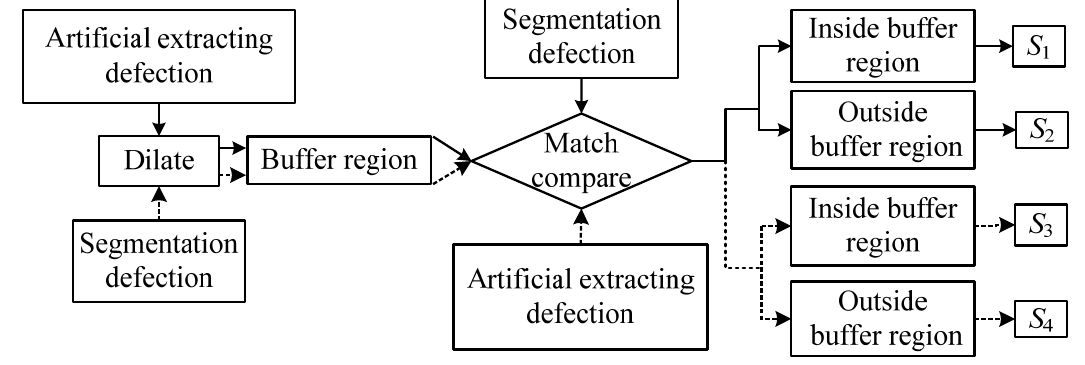
Figure 13. Flowchart of buffer region matching.